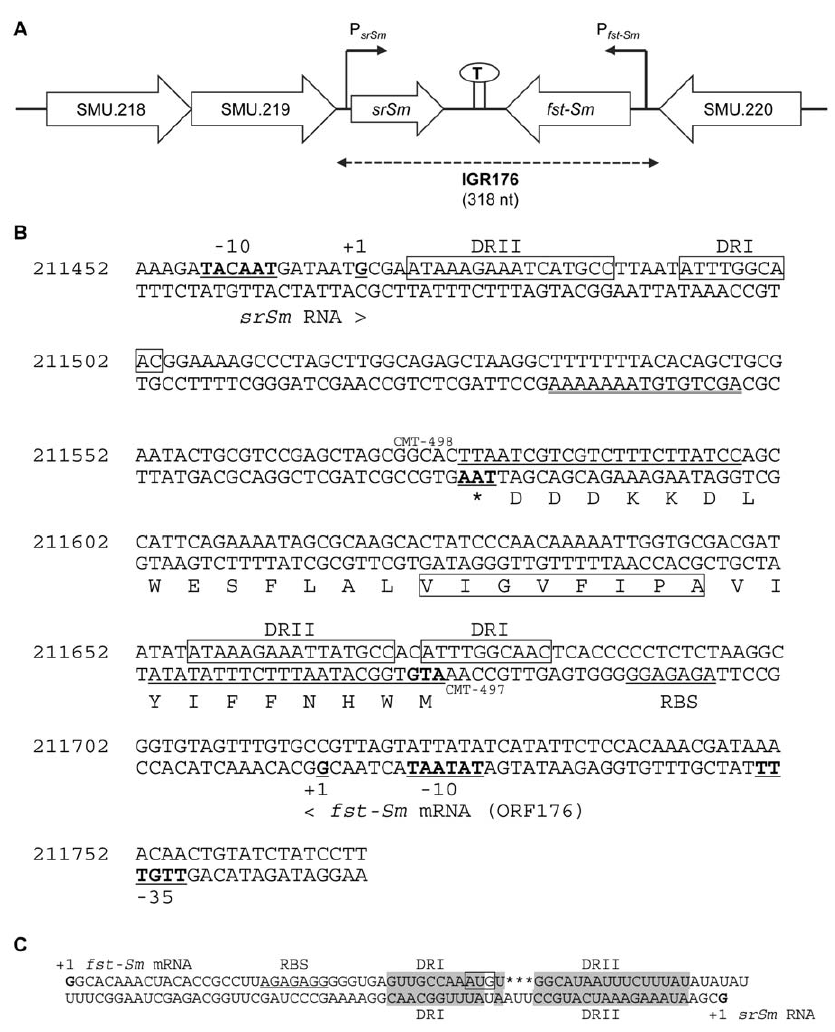
Figure 1. Analysis of S.mutans IGR176 region. ( A ) Schematic representation of the location of the fst-Sm / srSm locus on the S. mutans chromosome. Arrows indicate the direction of transcription. The fst-Sm and srSm promoter sequences are indicated by P fst-Sm and P srSm , respectively. A predicted stem-loop bidirectional terminator is indicated between srSm and fst-Sm . Shown at the bottom are the boundaries of the intergenic region IGR176. ( B ) Nucleotide and amino acid sequences of the S. mutans fst-Sm / srSm type I TA locus located in the intergenic region IGR176 (from 211452 to 211769) of UA159 genome. The conserved APUU(A/V)GUU motif present in Fst-Sm peptide is boxed. Putative promoter sites of fst-Sm toxin (–35, –10) and srSm antitoxin (–10), ribosome binding site (RBS) of Fst-Sm toxin, and a factor-independent bidirectional terminator (double underlined) are indicated. The transcriptional start site ( + 1) of fst-Sm and srSm identified by 5 9 RACE-PCR are indicated below the sequence. The regions encoding the DRI and DRII repeats are boxed. The primers CMT-497 and CMT-498 used in the RT-PCR experiments are underlined. ( C ) Proposed RNA:RNA interactions (in shaded regions) between fst-Sm mRNA and srSm RNA.